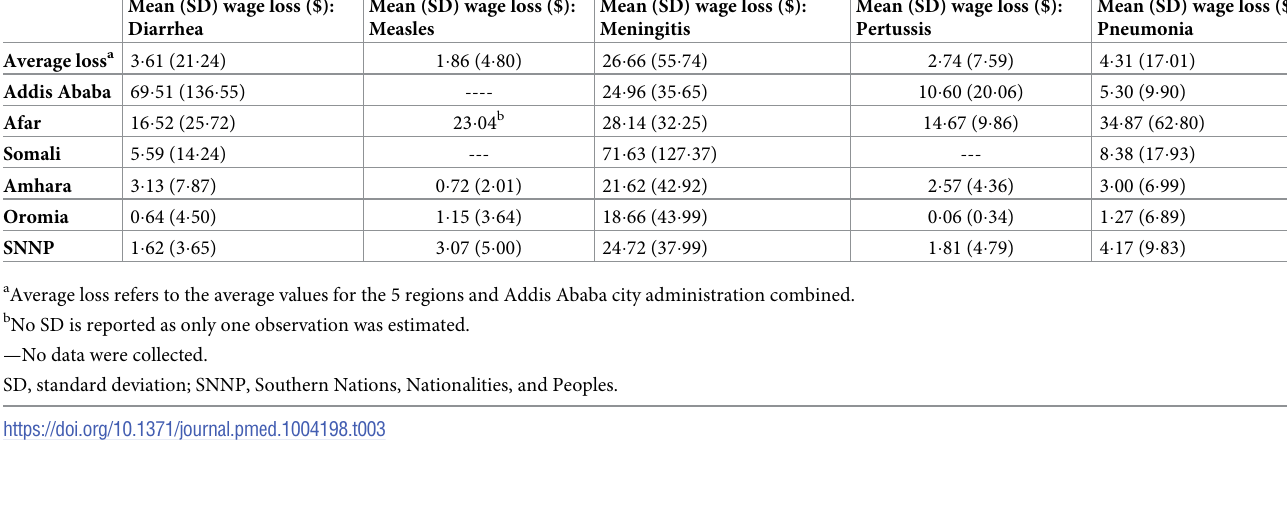
Mean (SD) wage loss ($): Pertussis